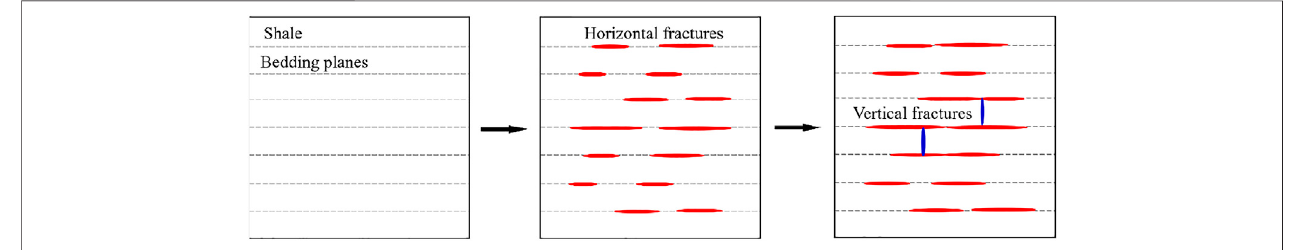
FIGURE 11 | Sketch map of the evolution of hydration